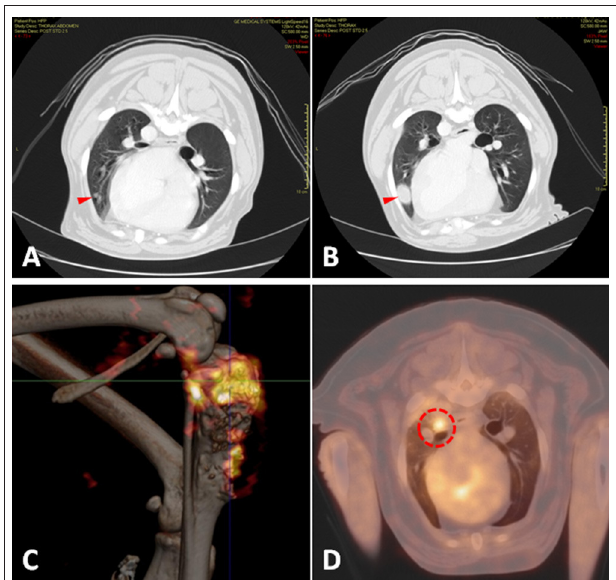
FIGURE 5 | Radiologic assessment and relevance of comparable anatomic size and metabolic activity of OS tumors arising in pet dogs. (A) Early detection of emerging pulmonary metastatic lesion (red arrowhead) with (B) subsequent rapid macroscopic growth (red arrowhead) over a period of 8 weeks documented by serial CT imaging. Metabolic activity of (C) primary bone OS (Image courtesy of Kim Selting, UIUC) and (D) pulmonary metastases (Image courtesy of Lynn Griffin, Colorado State University) using PET/CT imaging in pet dogs with OS. UIUC, University of Illinois at